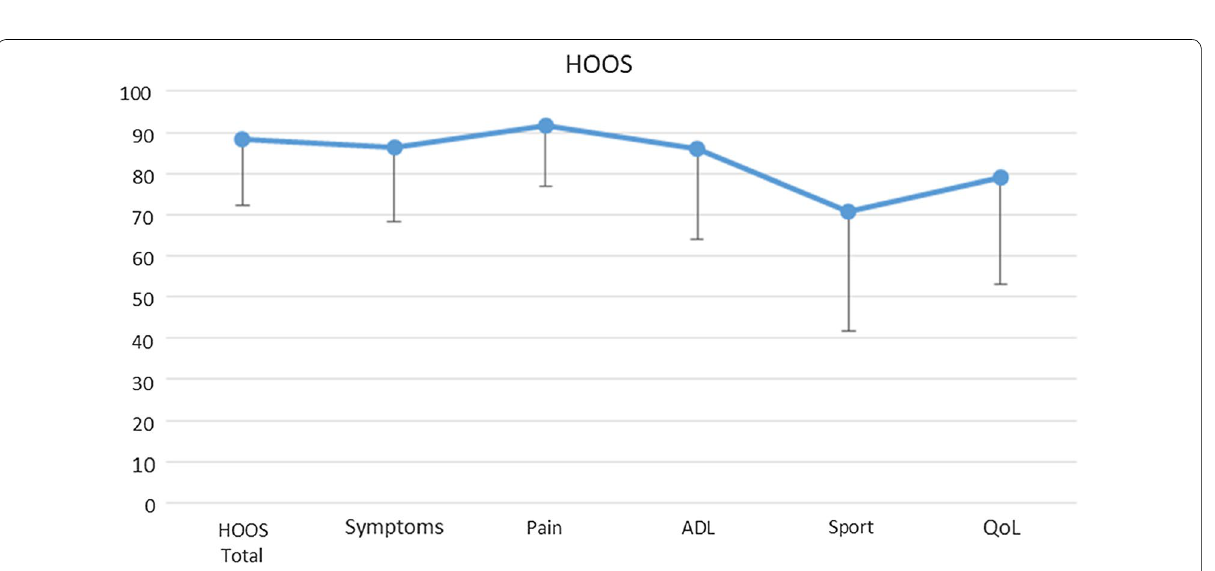
Fig. 2 Hip disability and Osteoarthritis Outcome Score (HOOS) and subscale